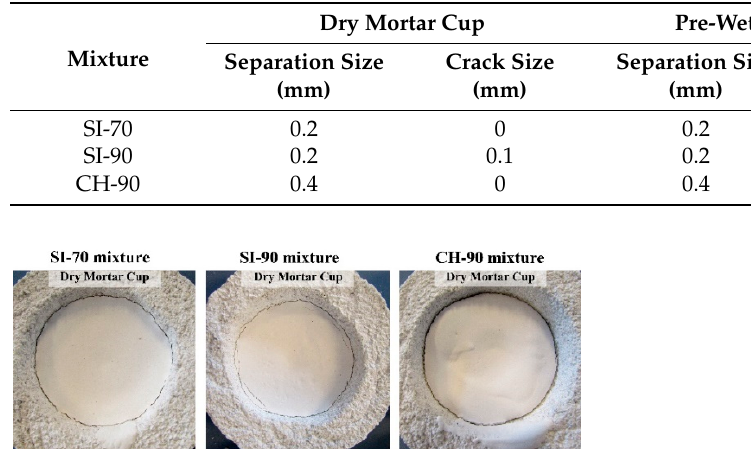
Table 6. Drying shrinkage in dry and pre-wetted mortar cups.